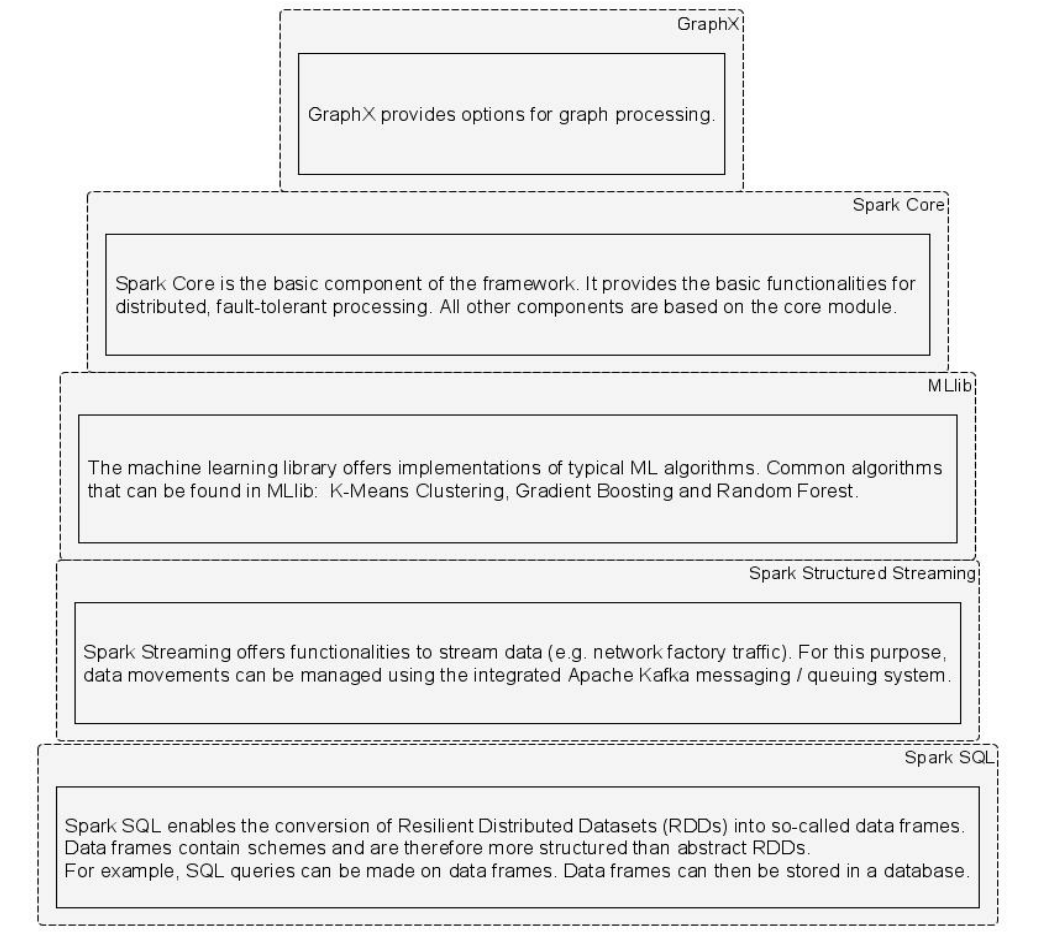
Figure 2. Apache Spark Framework.